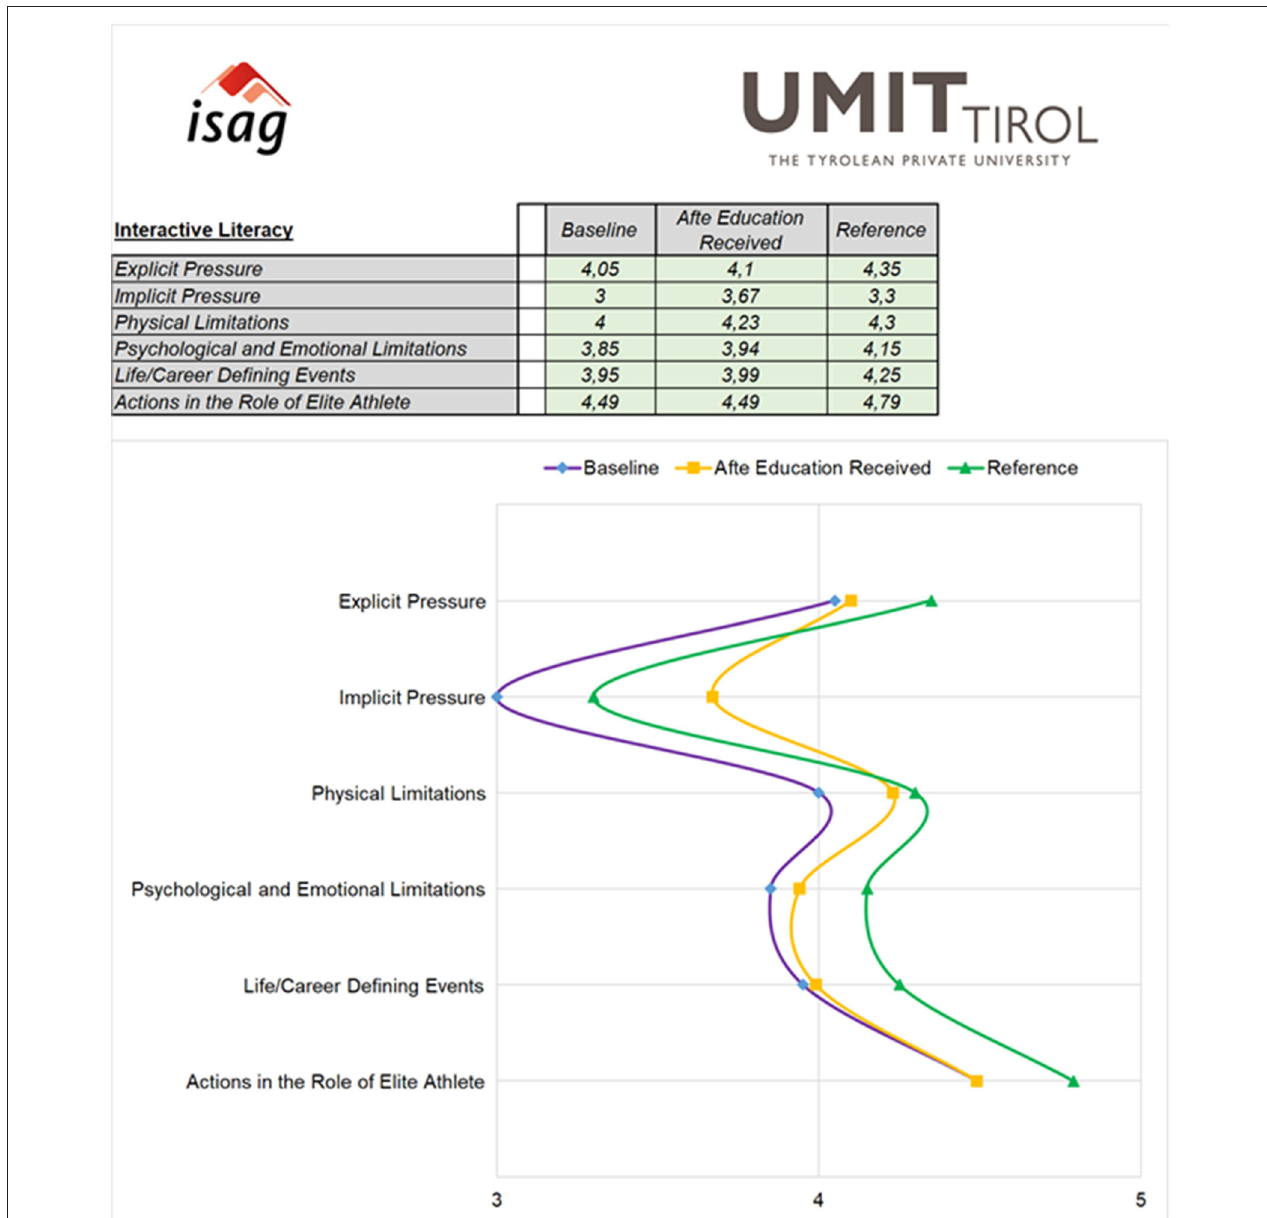
FIGURE 8 | Illustrative example of profile graph (excel template) for